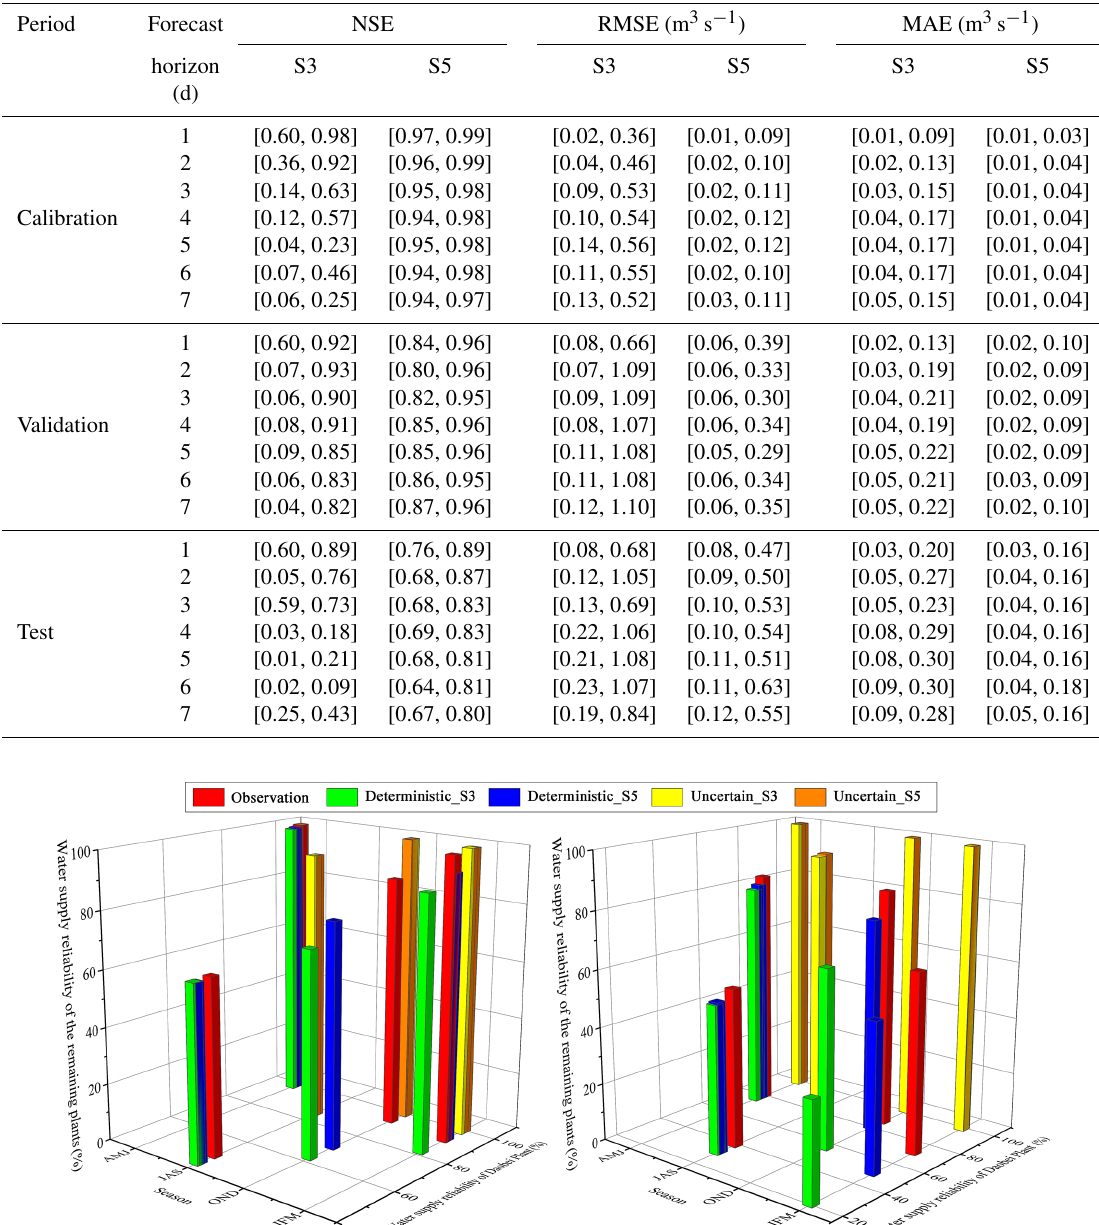
Table 4. Performance metric ranges ([min, max]) for all 24 reservoirs of BMA methods under S3 and S5.